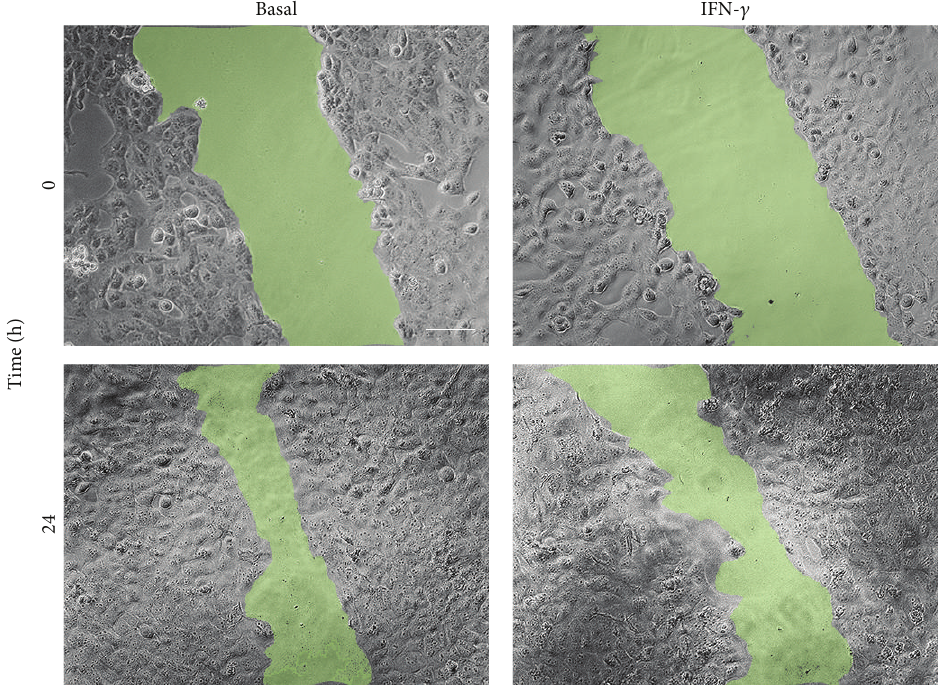
Figure 5: Wound-healing assay for BCPAP cells in basal condition (time 0: 0%; after 24h: 51.1% of wound closure) and after treatment with IFN 𝛾 (time 0: 0%; 24 h: 38.3% of wound